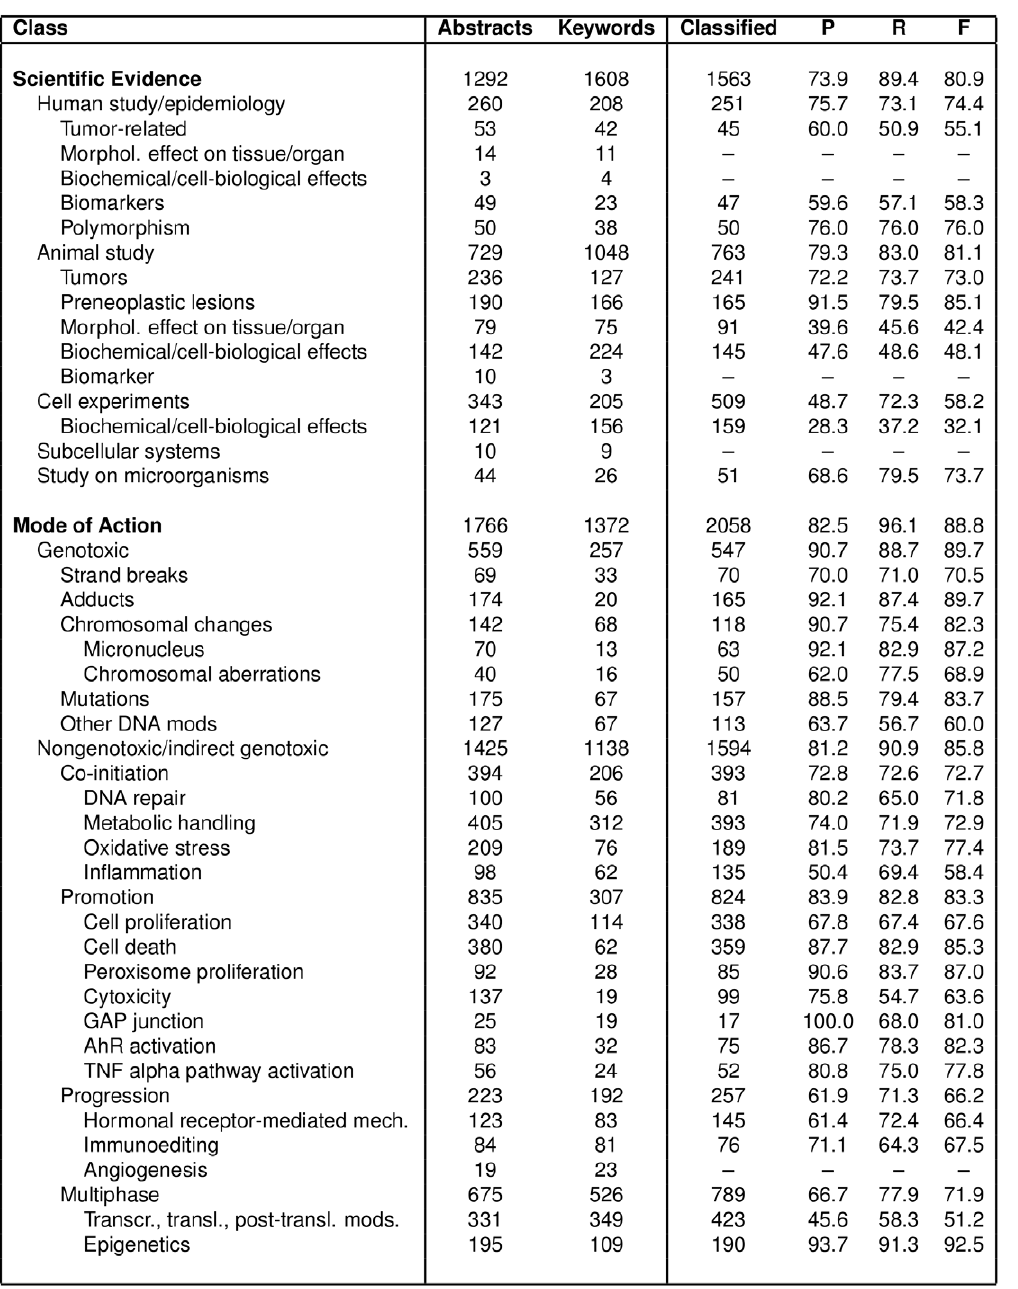
Figure 5. Classification results: number of abstracts and distinct keyword annotations for each label; number of abstracts classified as positive by the system; Precision, Recall and F-measure.